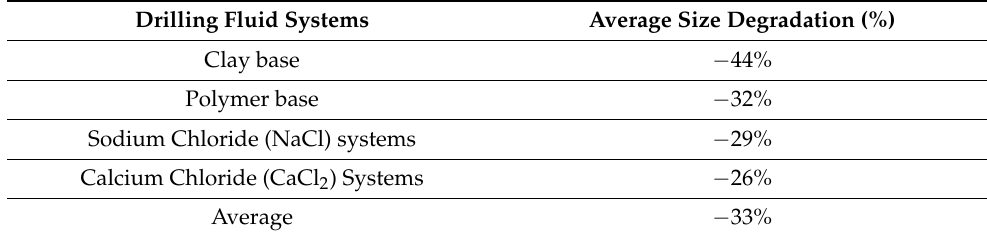
Table 7. Marble size degradation (30 min shearing